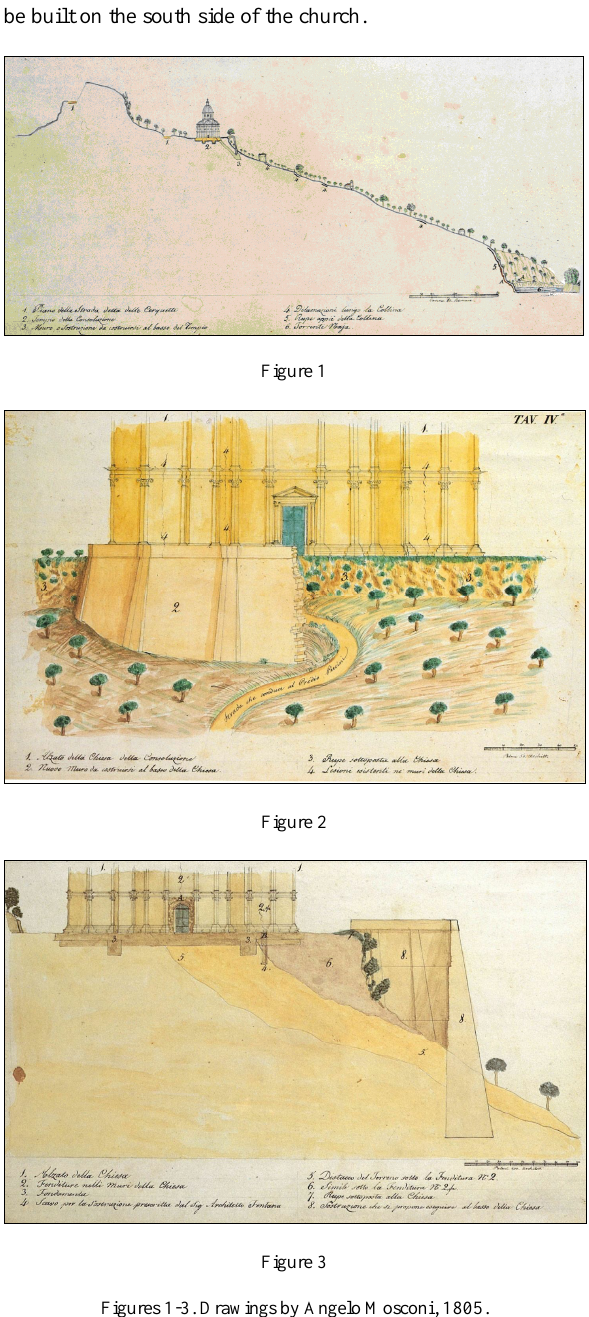
Figures 1-3. Drawings by Angelo Mosconi, 1805. From top: Profile of the slope were the church is built - Prospect from south with the left half of the designed wall - Prospect from west and section of the designed wall Figure 2 ( Tav. IV in the original drawing) shows a view of the church along the west-east direction and the land around. The main vertical cracks observed on the structural walls are also shown. A half of the new massive wall is represented on the left side while the right side shows the existing situation with a view of the scarp.